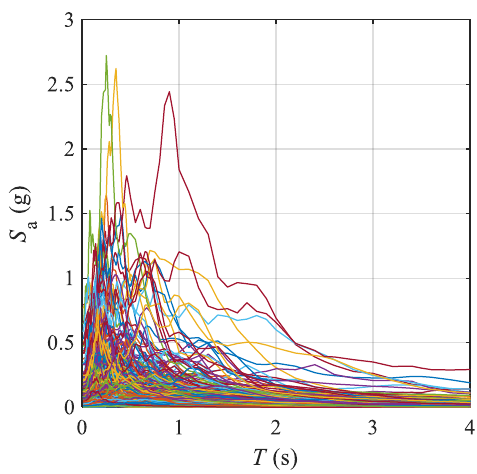
Figure 3. Acceleration response spectra of partial ground motions.